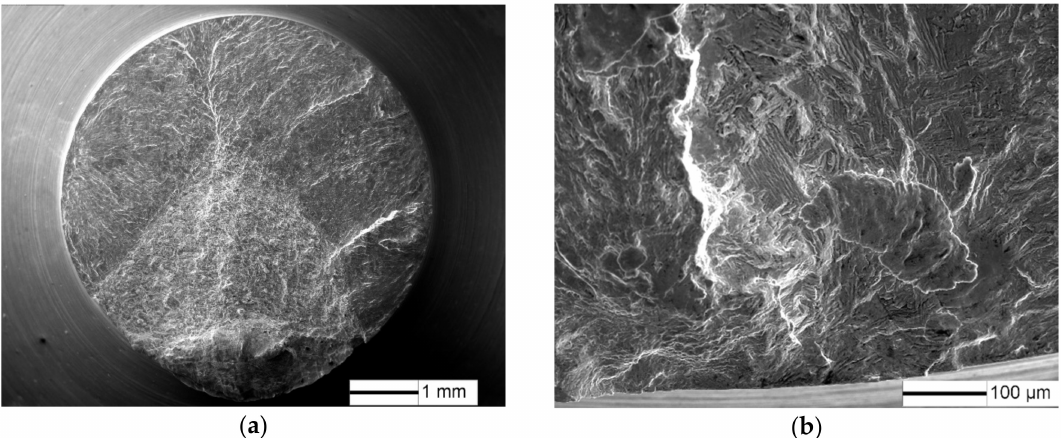
Figure 8. Fracture surface for the notch specimens at σ = 400 MPa and N = 1.25 × 10 5 cycles: ( a ) macroscopic morphology, and ( b ) crack initiation